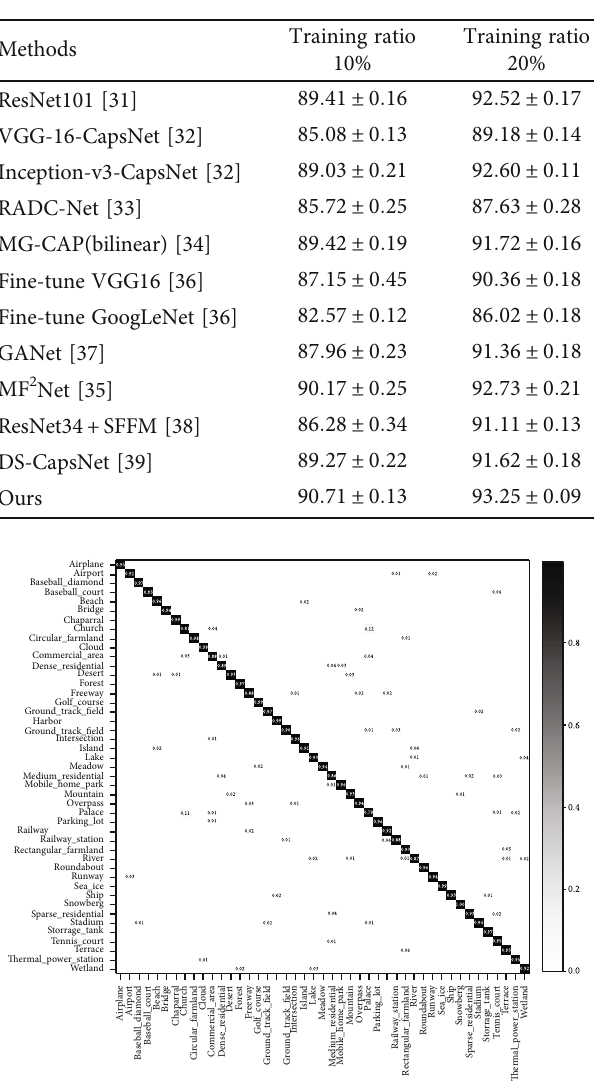
Table 6: Overall accuracy (%) comparison with other method on NWPU-RESISC45 data set.